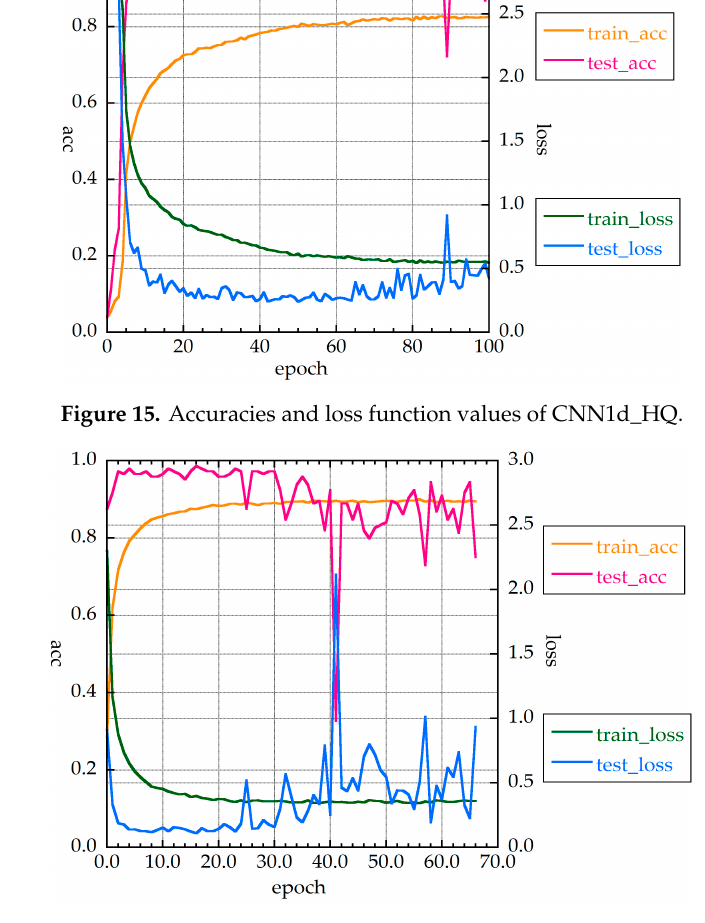
Figure 17. Accuracies and loss function values of CNN2d_Hi_HQ.